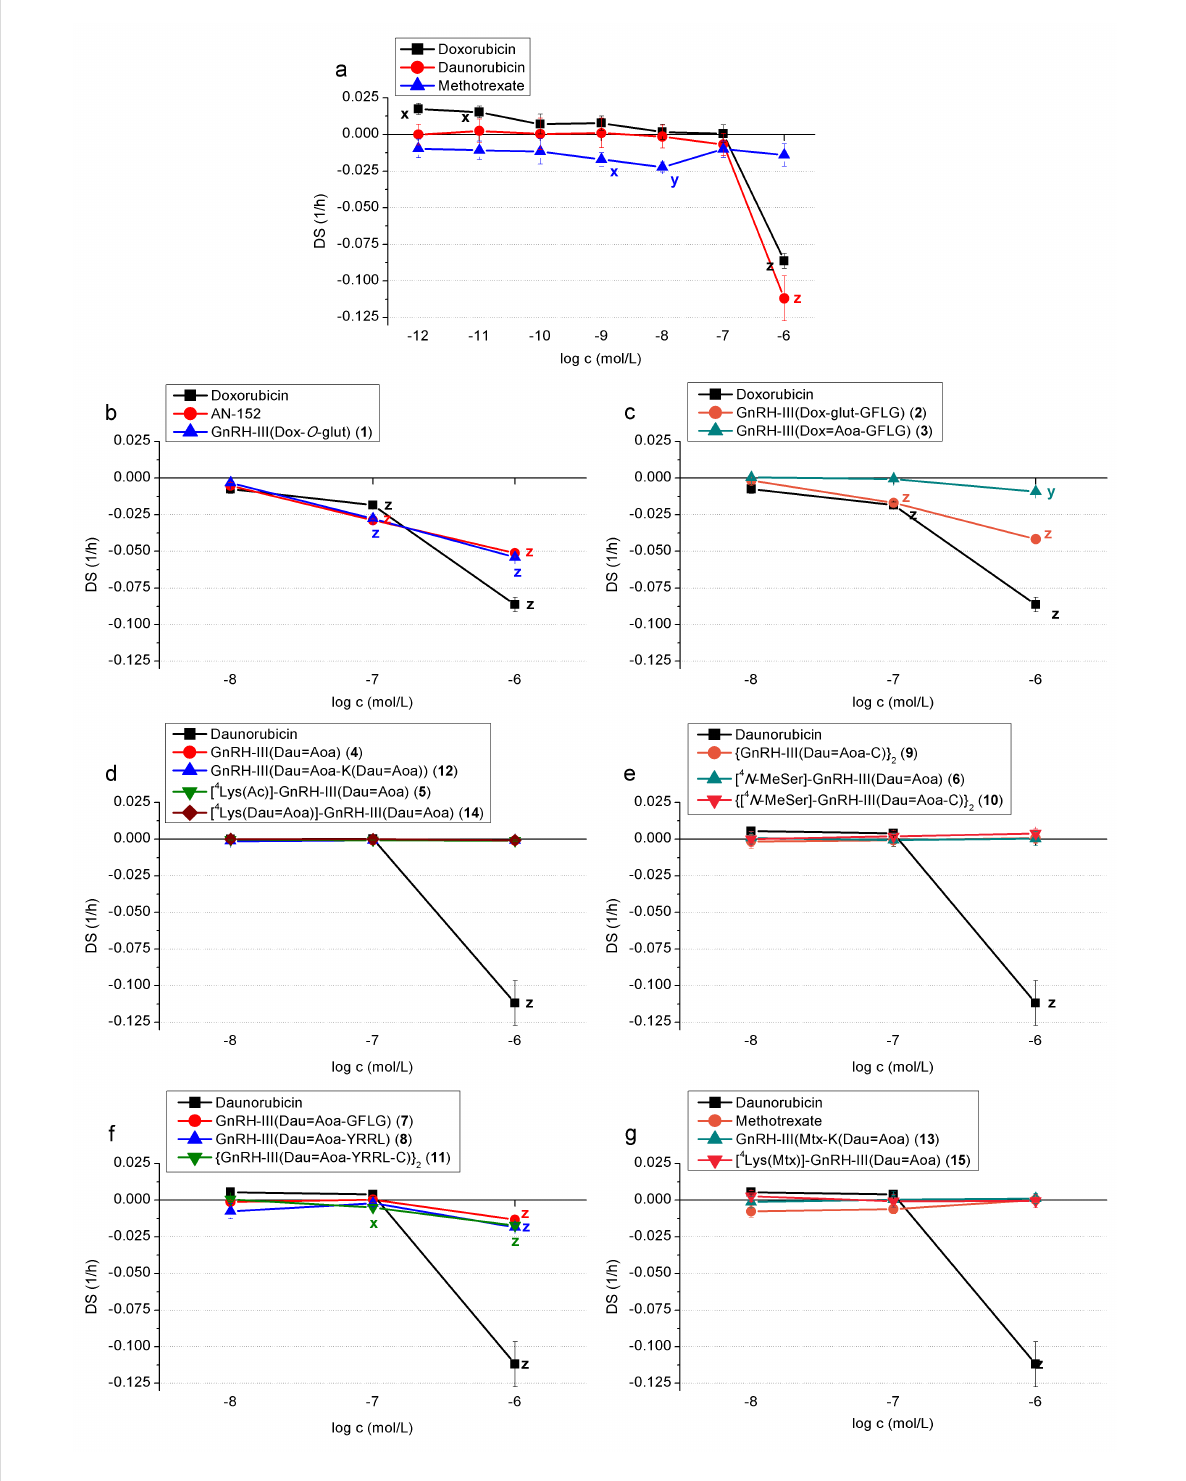
Figure 3: Long-term cytotoxic effects – impedimetrically registered negative effect on cell proliferation/viability – of chemotherapeutic drugs (doxoru- bicin, daunorubicin, methotrexate) and their GnRH-III conjugates on HUVEC cells. (a) Chemotherapeutic drugs (doxorubicin, daunorubicin, metho- trexate); (b) GnRH conjugates containing doxorubicin without spacer sequence; (c) with spacer sequence GFLG; (d) oxime bond-linked, mono- and bifunctional daunorubicin-GnRH-III conjugates without spacer and modified in position 4 with Lys; (e) {GnRH-III(Dau=Aoa-C)} 2 dimer and conjugates modified in position 4 with N -MeSer; (f) GFLG or YRRL spacer containing monomer and dimer conjugates (g) GnRH-III conjugates containing metho- trexate and